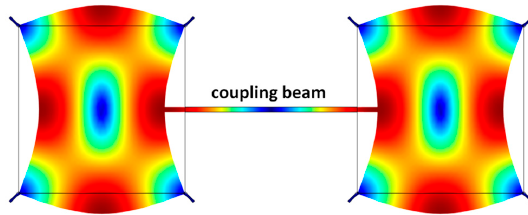
Figure 11. Array of Lamé mode resonators realized through mechanical coupling.